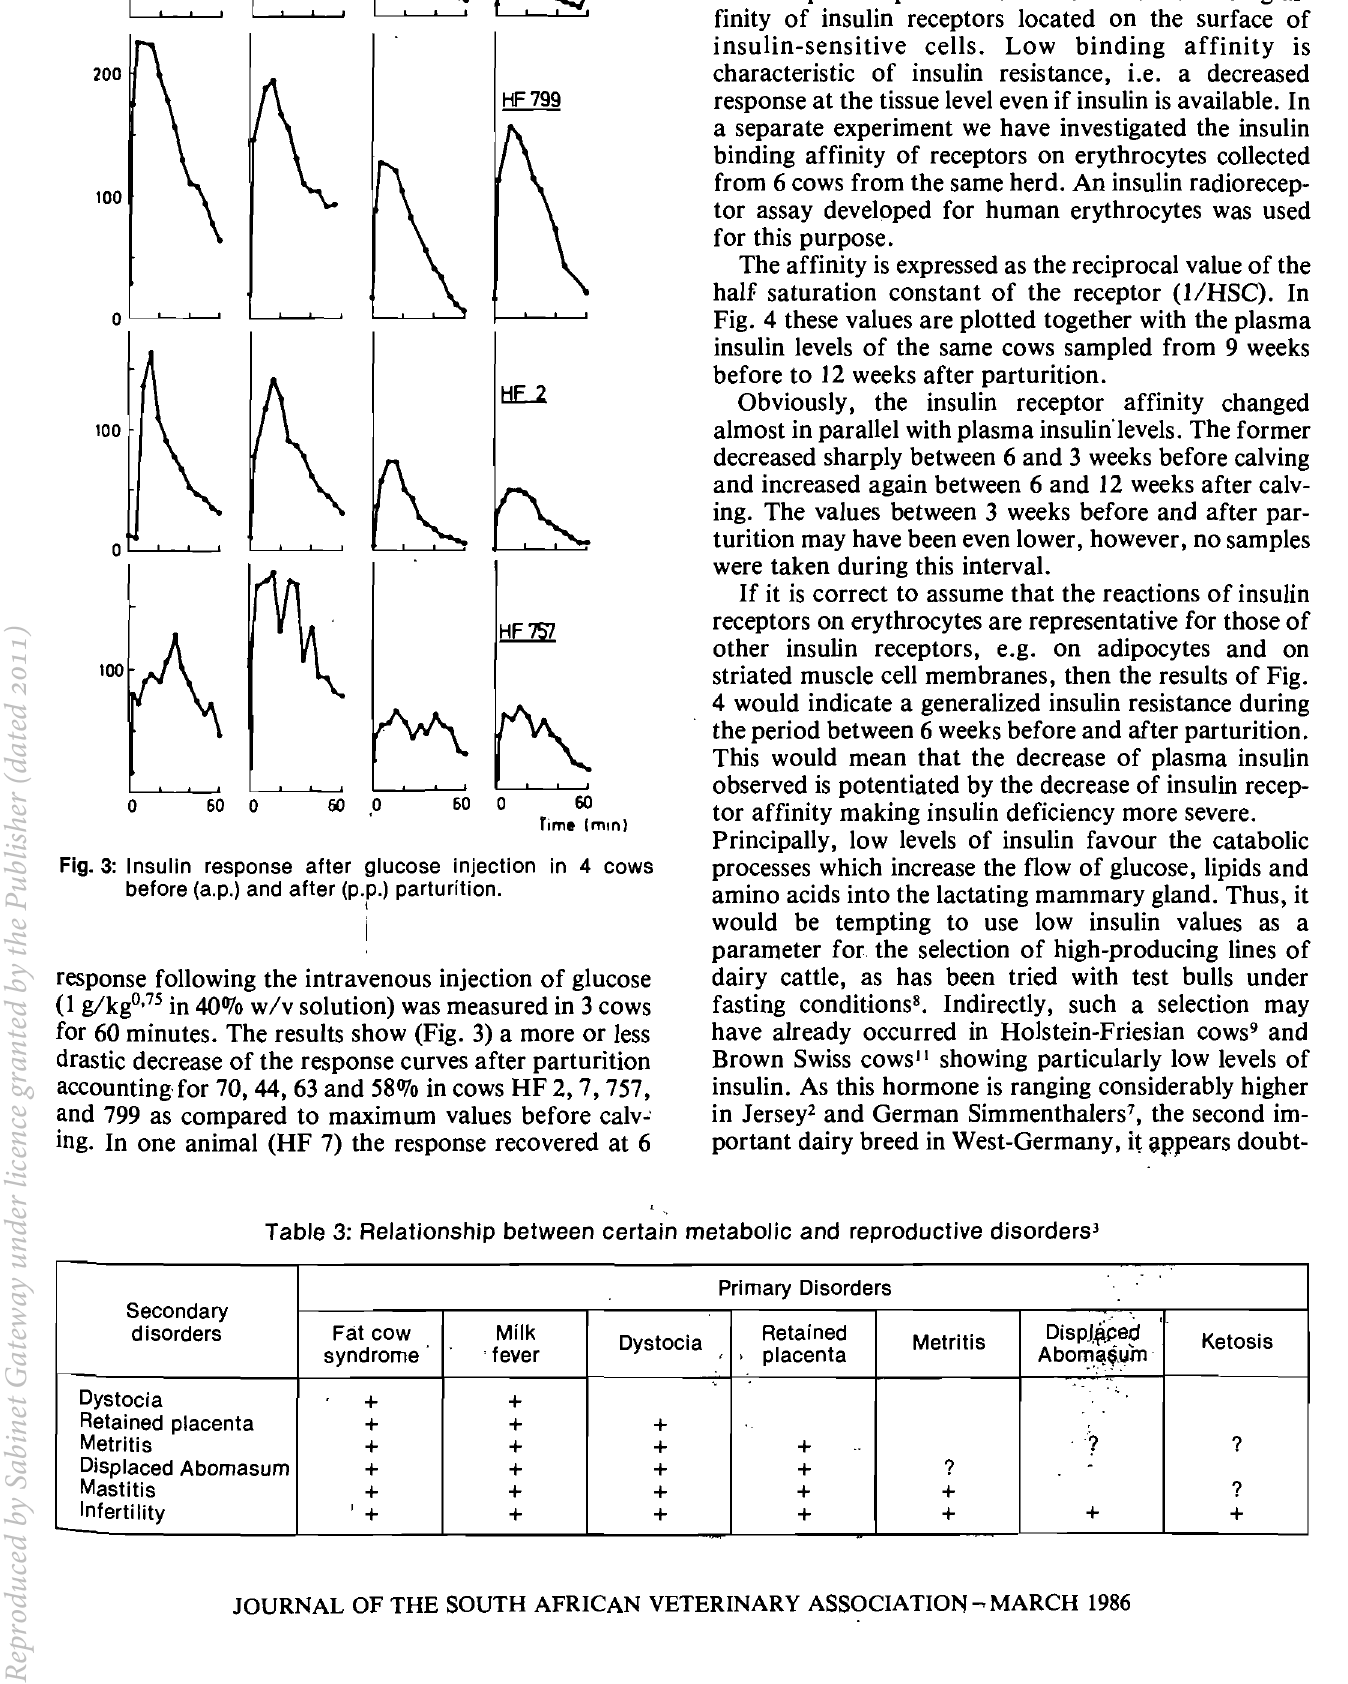
response following the intravenous injection of glucose (1 glkgO,75 in 40070 w/v solution) was measured in 3 cows